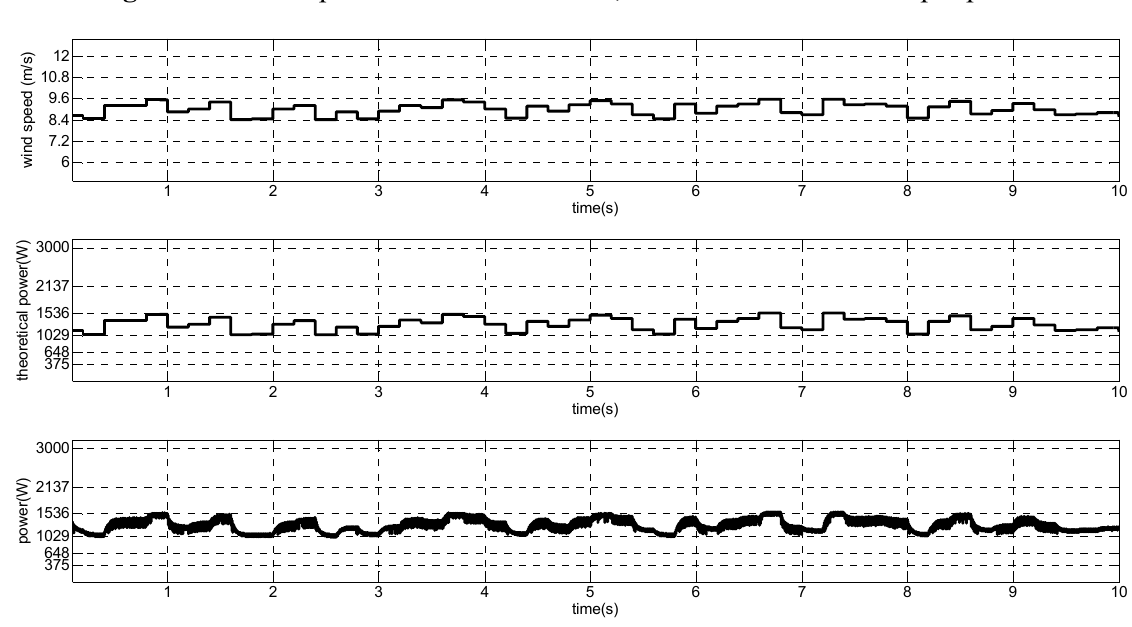
Figure 24. Wind speed with random behavior, theoretical MPP and output